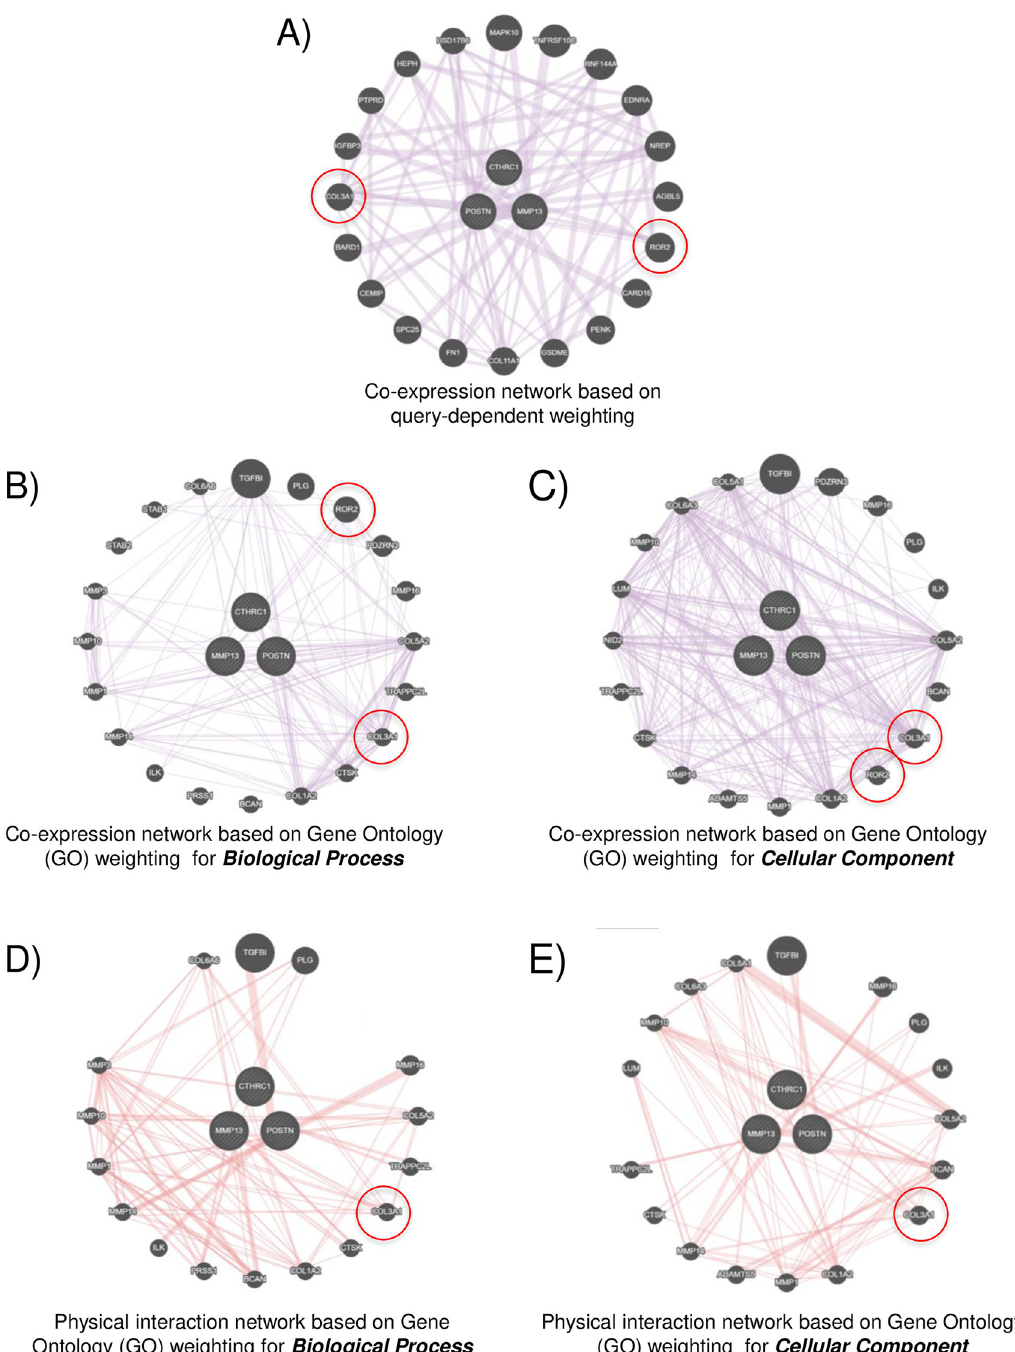
Fig 8. Functional Network analysis of CTHRC1, POSTN and MMP13. Network analysis of CTHRC1, POSTN and MMP13 identifies COL3A1 in both co-expression and physical interaction categories. A) Image shows co-expression network based on query genes, B-C ) Images shows co-expression network based on (B) biological processes and (C) cellular component. ( D-E) Image shows physical interaction network based on (D) biological processes and (E) cellular component.